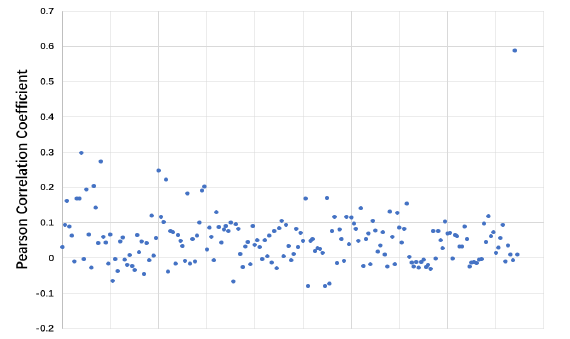
Figure 9. The Pearson correlation coefficient between labels in ICD-9 Code tasks on MIMIC-III. x -axis, the label pair id in ICD-9 Code tasks; y -axis, Pearson correlation coefficient between labels.